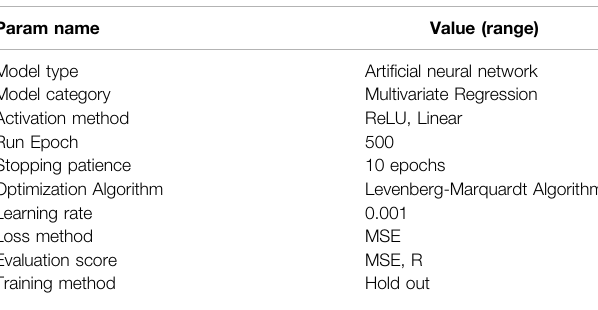
TABLE 2 | Simulation